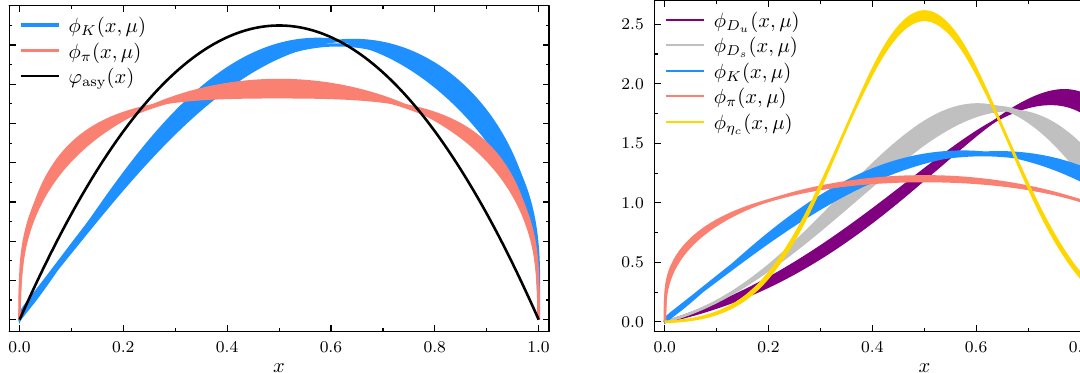
( x ,μ) , φ ( x ,μ) and φ η ( x ,μ) . The D s u c